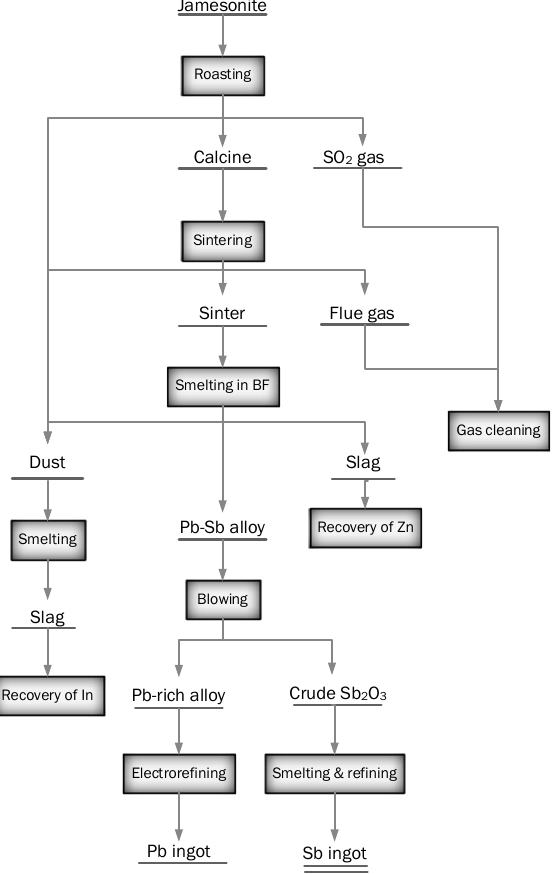
Figure 13. Flow diagram of roasting-sintering-smelting of jamesonite in blast furnace (adapted from [19]).